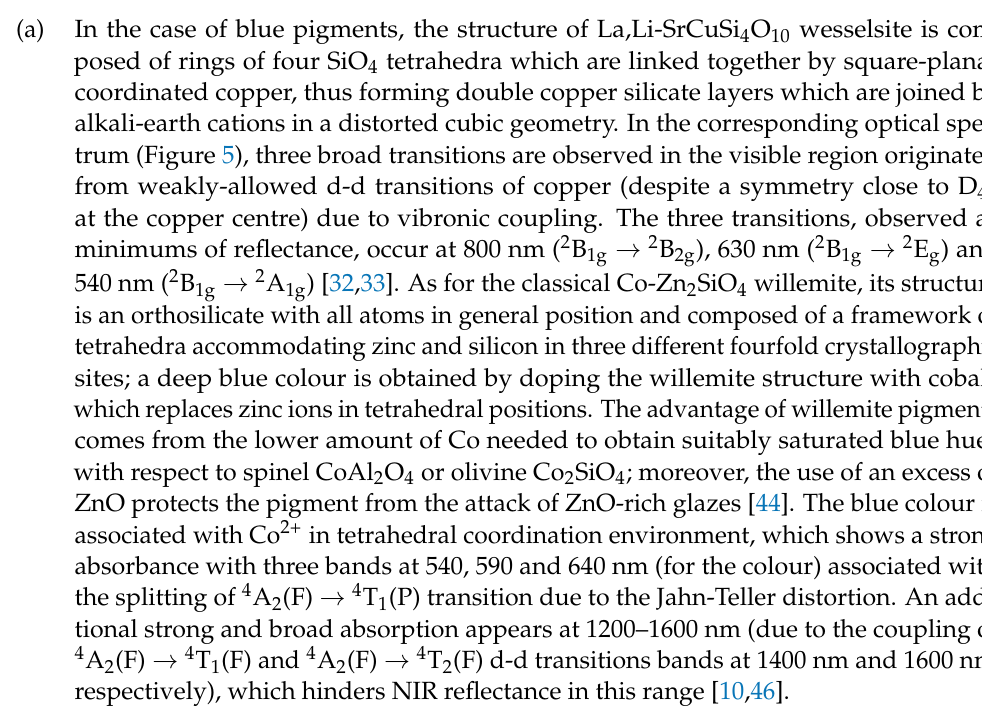
Figure 5. UV-Vis-NIR Reflectance spectra of powders of the both families of pigments.